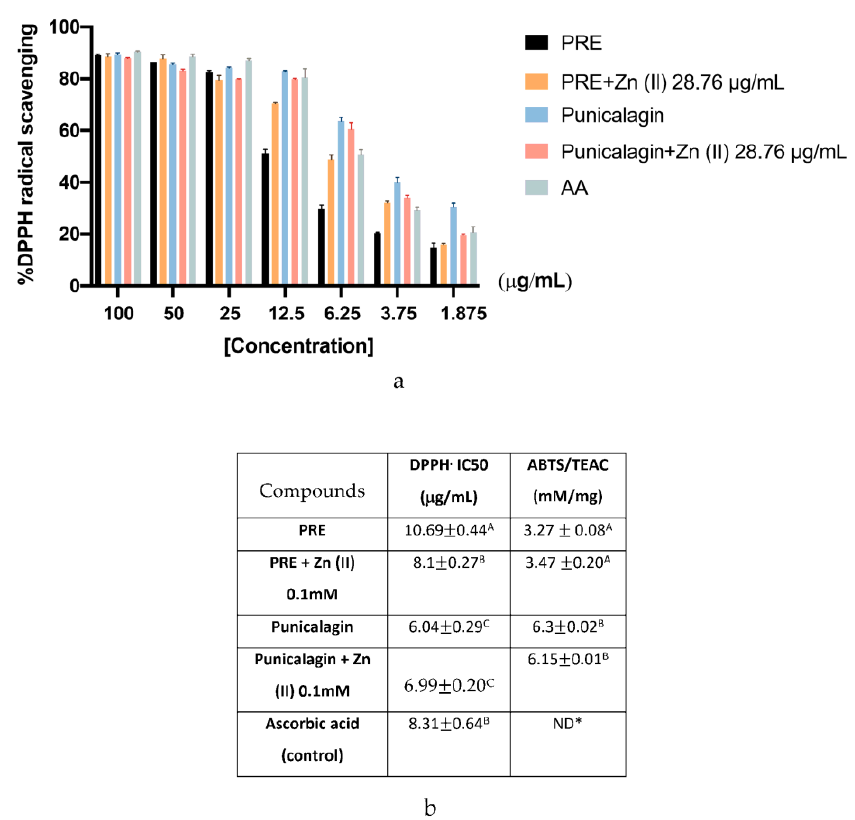
Figure 2. Antioxidant capabilities of PRE and punicalagin alone and in combination with 28.76 µ g / mL (0.1 mM) Zn (II). ( a ) % DPPH antioxidant scavenging capacities at di ff erent sample concentrations. ( b ) TEAC values obtained for each sample, based on the finding of the ABTS assay. Values are presented as the mean ± SEM ( n = 3). TEAC, Trolox equivalent antioxidant capacity. Values followed by the same capital letter within the same column are not significantly di ff erent (p > 0.05) between the compounds analyzed by Duncan’s multiple range test. * ND; not determined.